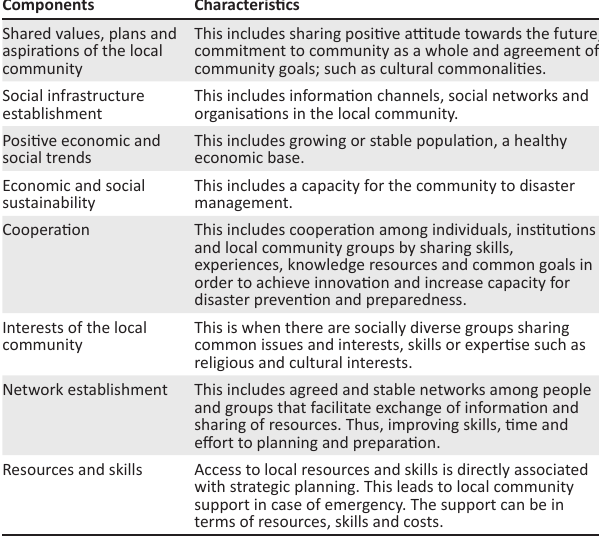
TABLE 2: Components and characteristics of social